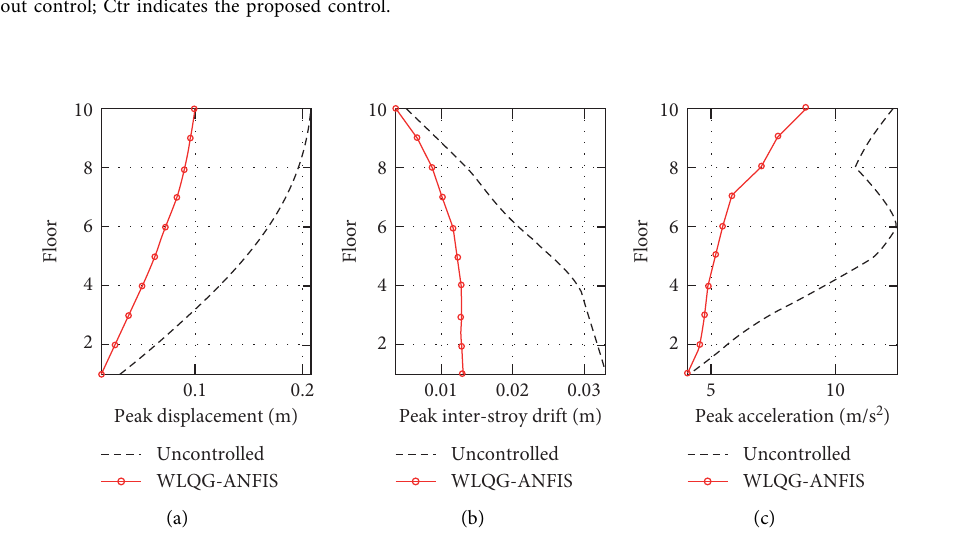
Figure 26: Peak responses with consideration of 15% stiffness